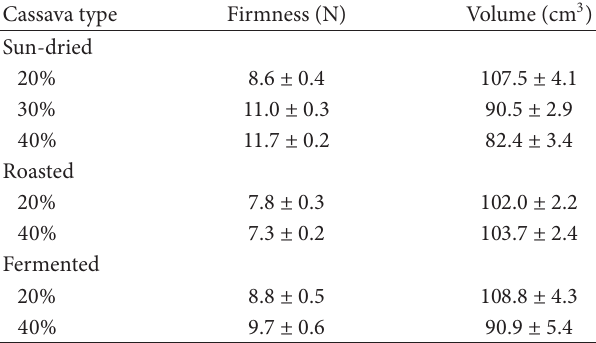
Table 3: Mean values of firmness (N) and volume (cm 3 ) for bread types made with sun-dried, roasted, and fermented cassava. The means for the different cassava ratios with the standard error being due to white noise and to the influence of pectin